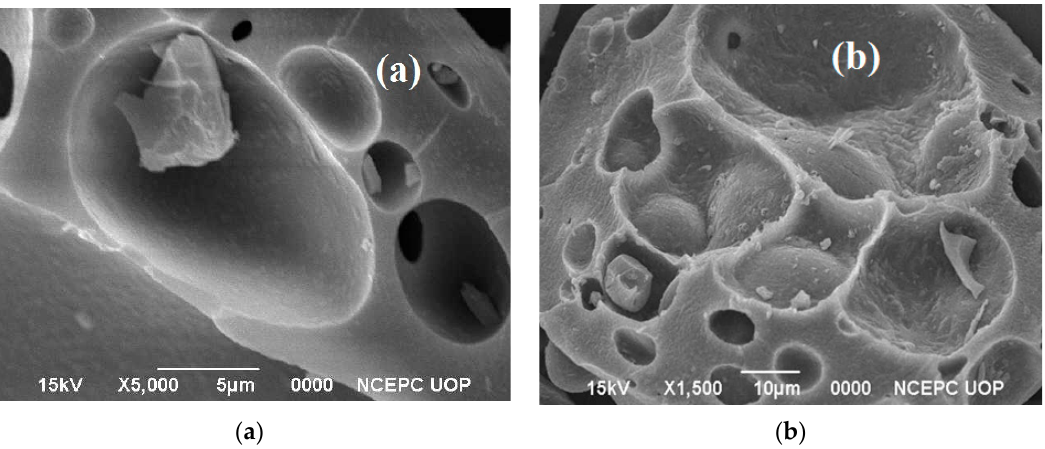
Figure 3. SEM images of biochar obtained from ( a ) non ‐ catalytic and ( b ) catalytic reactions.